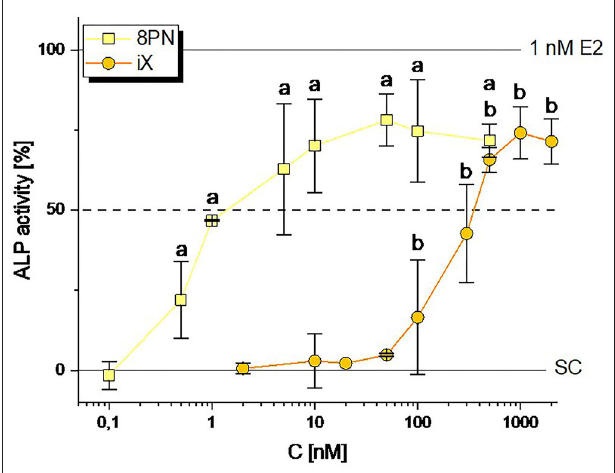
FIGURE 2 | Induction of ALP expression by the hop polyphenols 8-prenylnaringenin (8PN) and isoxanthohumol (iX). Values were scaled to the solvent control (0; 0.1 % DMSO) and the positive control (1nM E2, 100%) and are expressed as means ± SD of at least 4 independent experiments. Significant differences to the no-effect-level were calculated by one-way ANOVA, followed by Fisher LSD post-hoc testing, and are indicated by “a” or “b” ( p < 0.05). SC, solvent control.